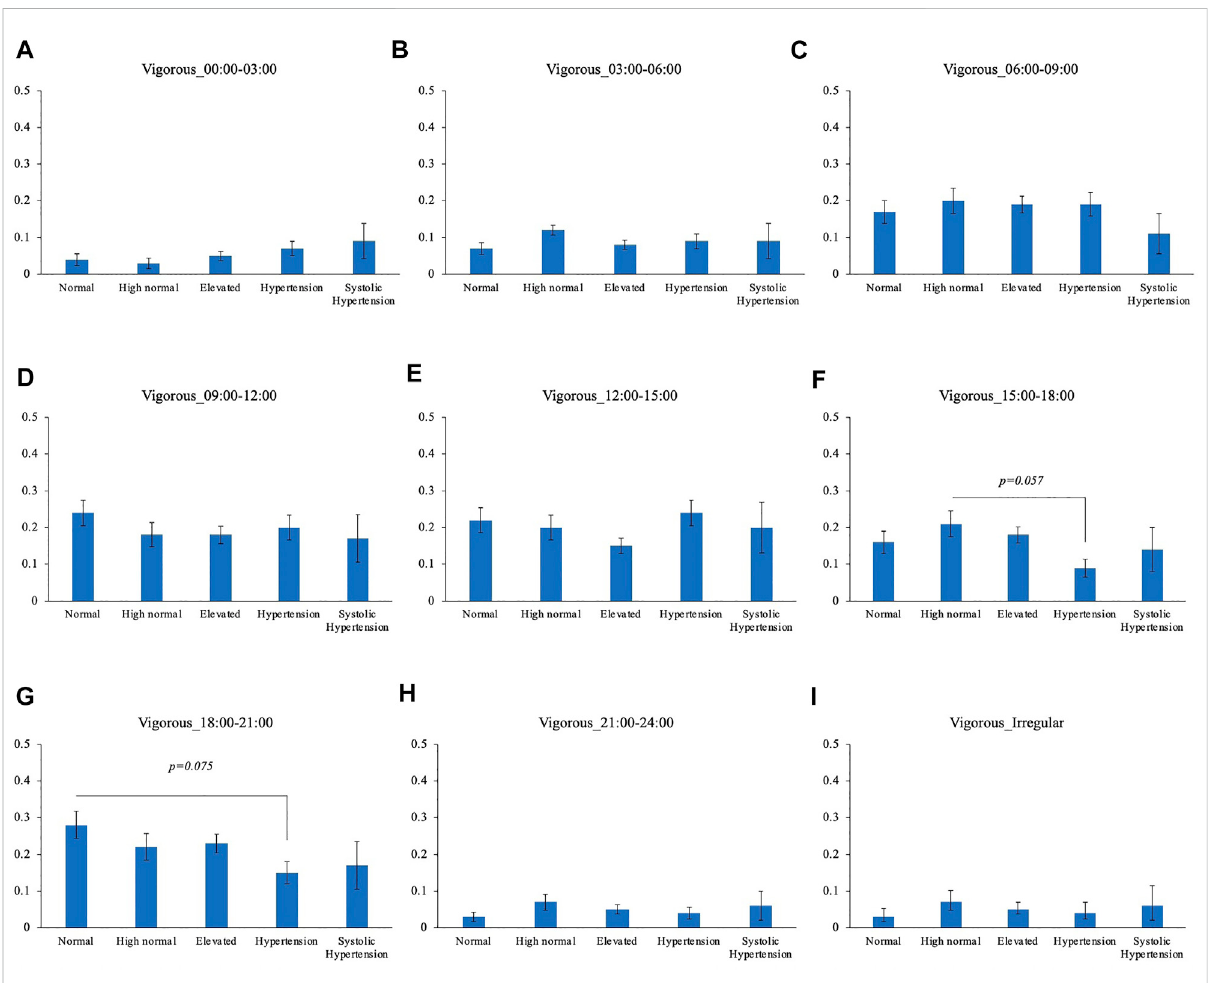
BPcategoriesandvigorousphysicalactivityfrequencyforeachtimeperiod (A) 00:00 – 03:00 (B) 03:00 – 06:00 (C) 06:00 – 09:00 (D) 09:00 – 12: 00 (E) 12:00 – 15:00 (F) 15:00 – 18:00 (G) 18:00 – 21:00 (H) 21:00 – 24:00 (I) Irregular timing* p < 0.05